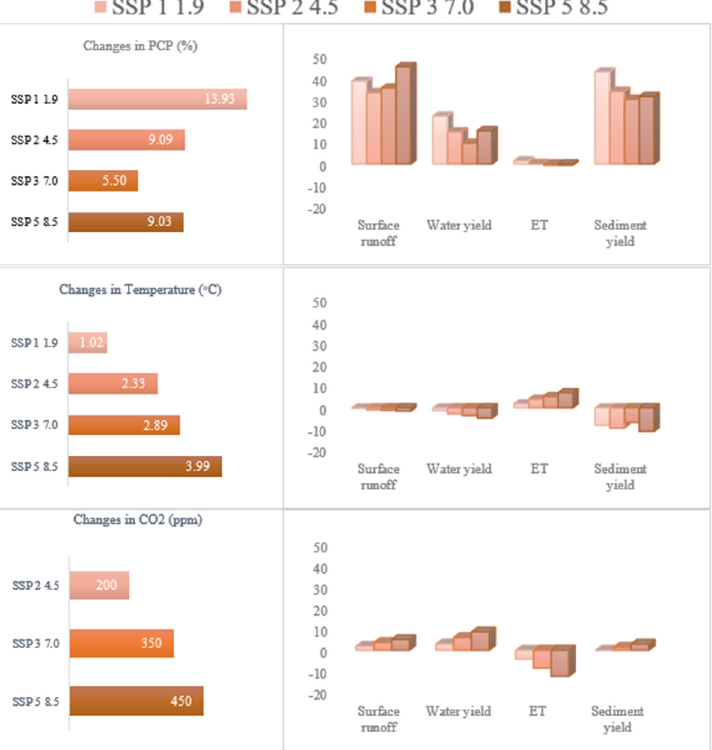
Figure 5. Changes in precipitation, temperature, and atmospheric [CO 2 ] for different SSPs (left) and their individual impacts on the hydrological parameters (% change) (right).